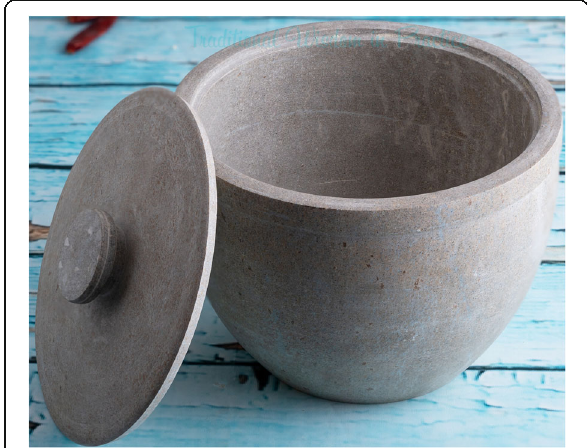
Fig. 8 The rathi chippa used for setting and storing